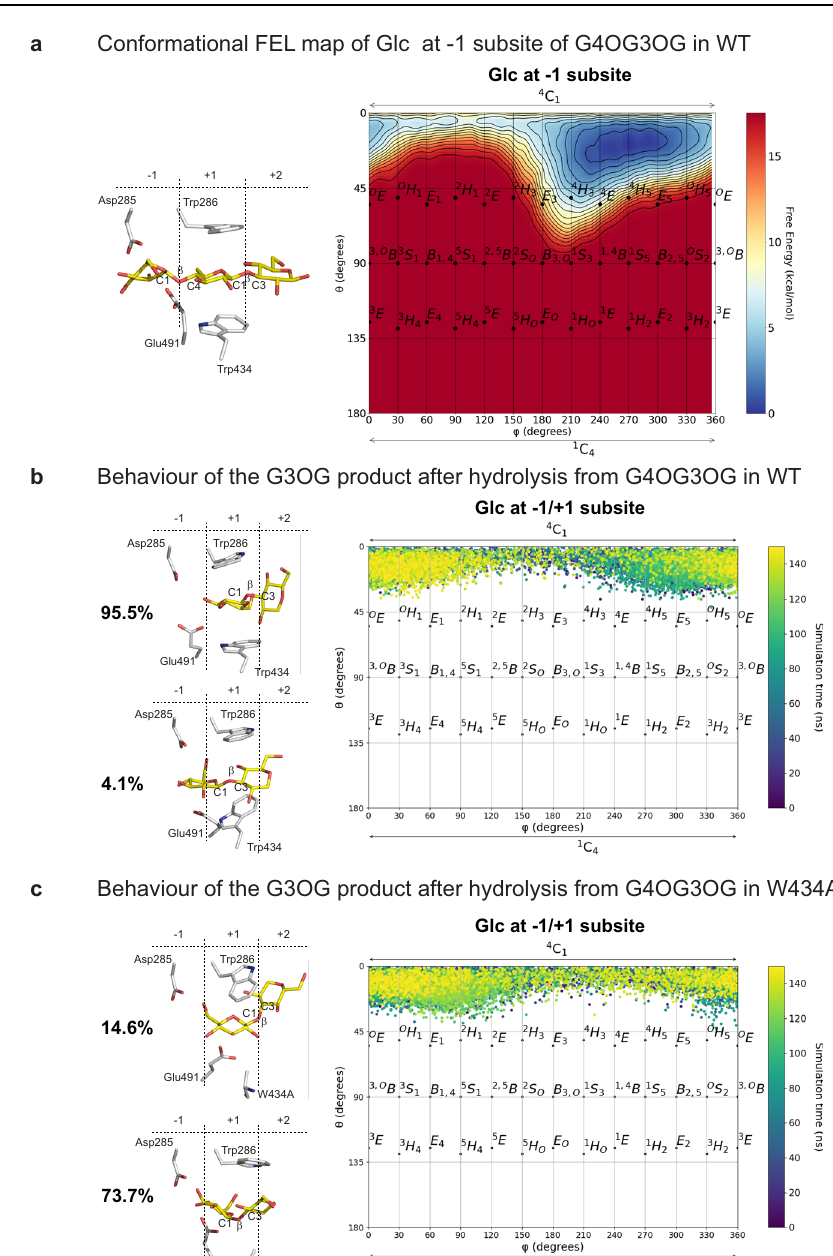
Fig. 6 | Binding of the G4OG3OG natural substrate in the HvExoI active site calculated via cMD and QM/MM MD metadynamics simulations, plotted as a functionof θ and φ puckeringcoordinates.a ConformationalFELmapoftheGlc moietyatthe − 1subsiteinWT;GlcmoietiesofG4OG3OGinthesubsites − 1to+2are indicated along with the key residues; b conformational behaviour (Mercator projection) of the G3OG product after the − 1 Glc moiety is hydrolysed from G4OG3OG and removed from the − 1 subsite in WT; c conformational behaviour